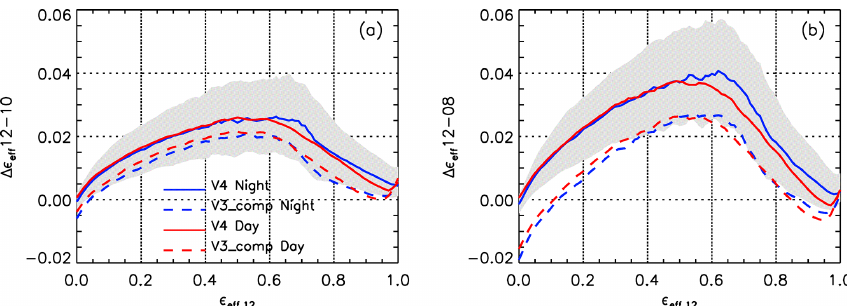
Figure 3. IIR inter-channel (a) (cid:49)ε eff 12–10 and (b) (cid:49)ε eff 12–08 effective emissivity differences vs. effective emissivity at 12.05µm in single- layered ice clouds over oceans between 60 ◦ S and 60 ◦ N in January 2008 in V4 (solid lines) and in V3_comp (dashed lines). The blue and red curves are median values for nighttime and daytime data, respectively. The shaded gray areas are between the V4 nighttime 25th and 75th percentiles.